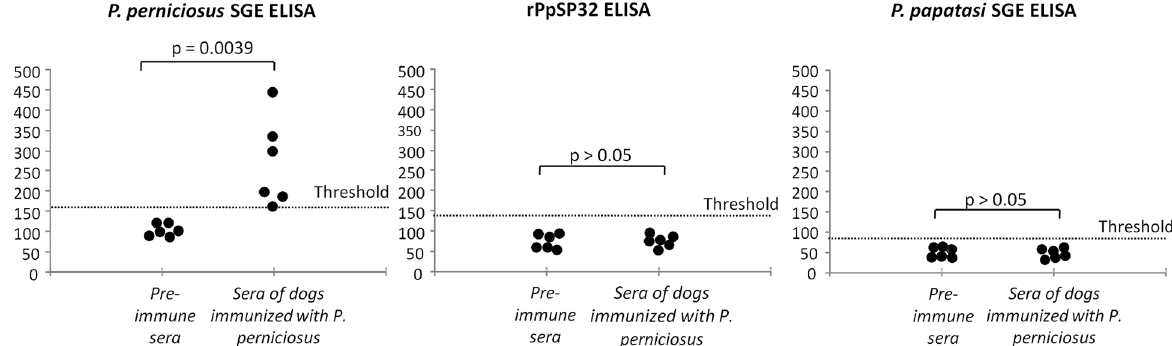
Fig 7. Analysis of cross-reactivity between P . papatasi SP32 and P . perniciosus saliva. The reactivity of immune and pre-immune sera obtained from dogs exposed to P . perniciosus bites was tested by ELISA against P . perniciosus salivary gland extract (SGE), rPpSP32 or P . papatasi SGE. The threshold of positivity was calculated as the mean optical density (OD) of pre-immune sera plus 3 standard